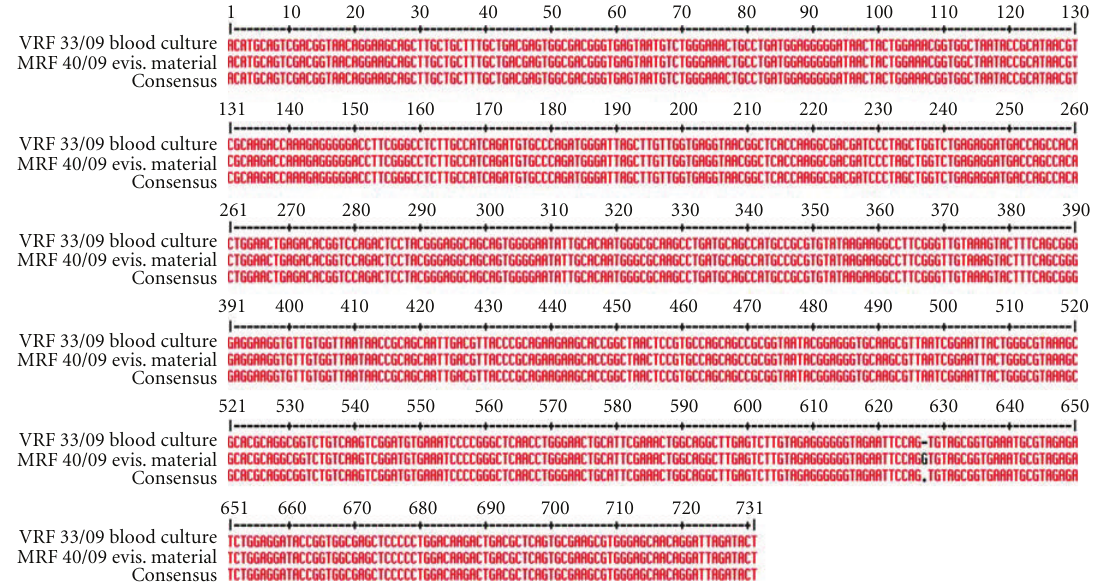
Figure 1: Multalin results showing 100% correlation of 16s rRNA gene of Salmonella typhi isolated from blood culture and eviscerated material.